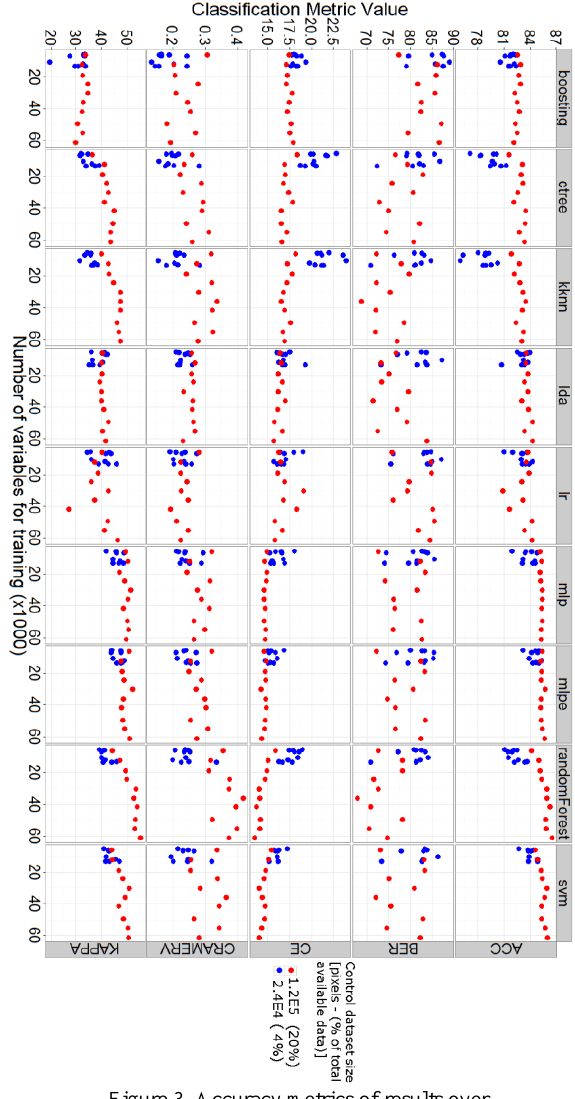
Figure 3. Accuracy metrics of results over the full independent